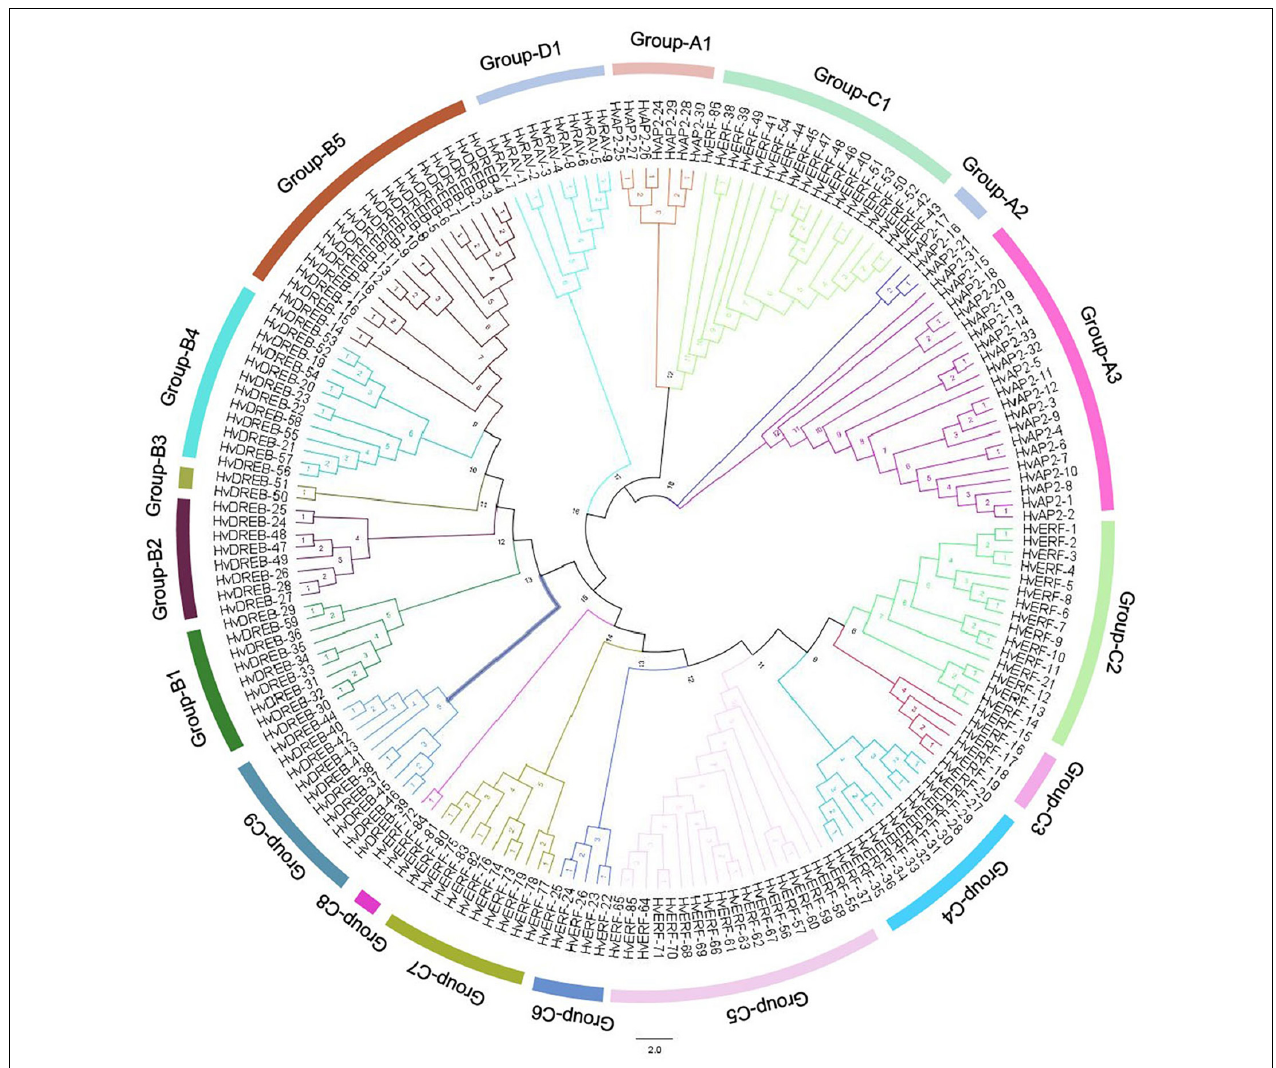
FIGURE 1 | Phylogenetic classification of barley HvAP2/ERF proteins. The 18 classes are represented by branches of different colors.